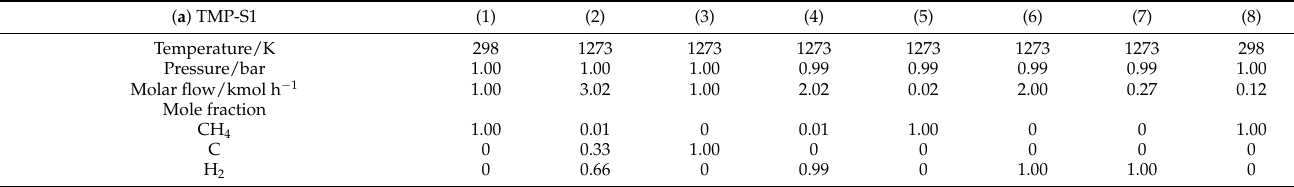
Figure 3. Block flow diagrams for methane pyrolysis (MP) systems of ( a ) thermal methane pyrolysis (TMP-S1), ( b ) catalytic methane pyrolysis (CMP-S2), and systems with additional gasification and WGS reaction of ( c ) TMPG-S3 and ( d ) CMPG-S4. Table 1. Material balance for methane pyrolysis (MP) systems of ( a ) thermal methane pyrolysis (TMP-S1), ( b ) catalytic methane pyrolysis (CMP-S2), and systems with additional gasification and WGS reaction of ( c ) TMPG-S3 and ( d ) CMPG-S4.